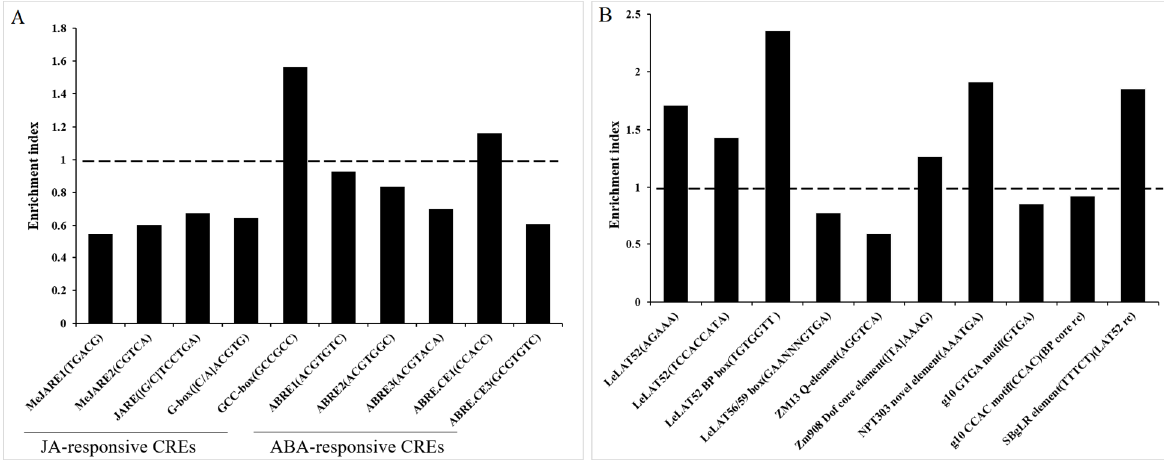
Figure 8. Enrichment analyses of known pollen-specific and ABA-/JA- responsive cis -elements in the promoters of MAPS. ( A ) Enrichment analyses of known pollen-specific cis -elements in MAPS promoters of. The actual frequency of 10 known pollen-specific cis -elements appeared in the 2-kb promoters of the 618 MAPS genes were counted by software Python 3.7.3. The expected frequency of a specific cis -elements occurred in a random DNA sequence can be simply calculated based on the sequence length. For example, the expected frequency of a 5-nt cis -element such as AGAAA was expected to be one time in a length of 4 5 -bp DNA. TCCACCA, a 7-nt cis -element was expected to meet once in 4 7 -bp DNA. The enrichment index is the actual frequency divided by the expected frequency. ( B ) Enrichment analyses of known JA- and ABA-responsive cis -elements in MAPS promoters.